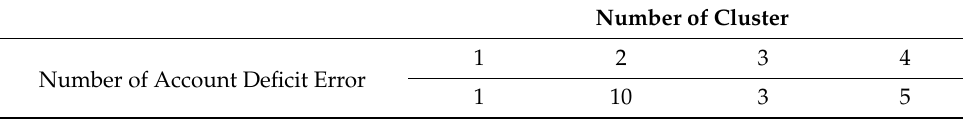
Table 5. Clustering of account deficit error (source: research analysis).